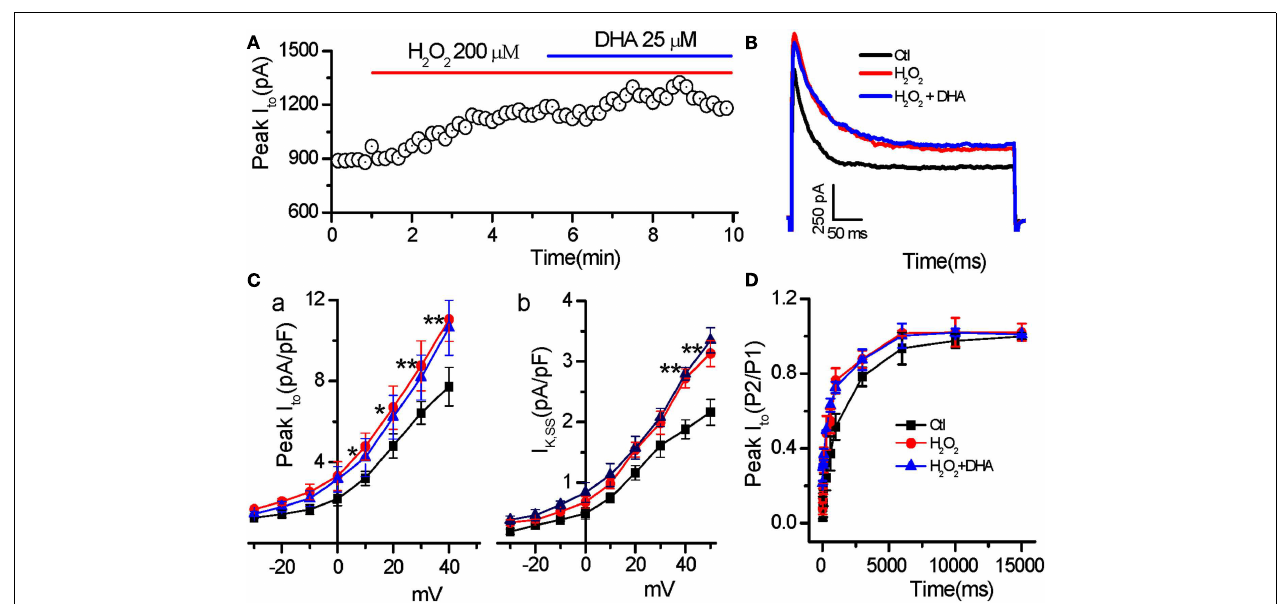
( I K,SS , C-b ) showing less effects of DHA on enhancement of peak I to and I K.ss ( n = 6, * p < 0.05, ** p < 0.01 vs. control.).Test potentials ranged from − 60 to + 50mV in 10mV steps. (D) Recovery of I to from inactivation showing no significant effect of DHA (25 µ M) on the I to recovery sped-up by H 2 O 2 (200 µ M; p > 0.05, n = 7).